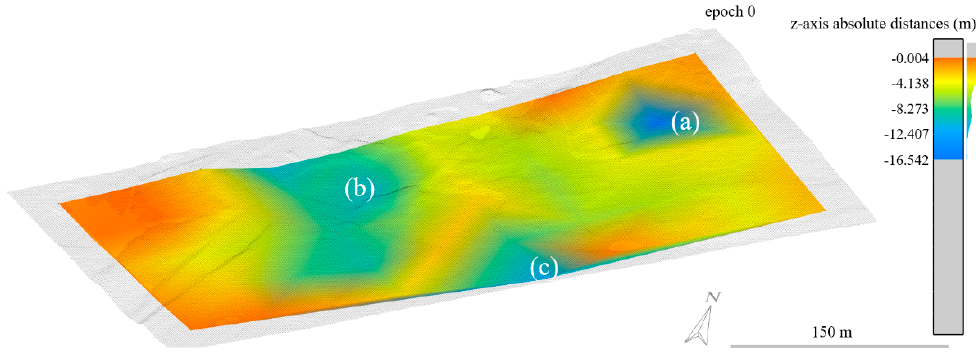
Figure 21. Initial epoch 3D point cloud compared to the estimated consolidated terrain.